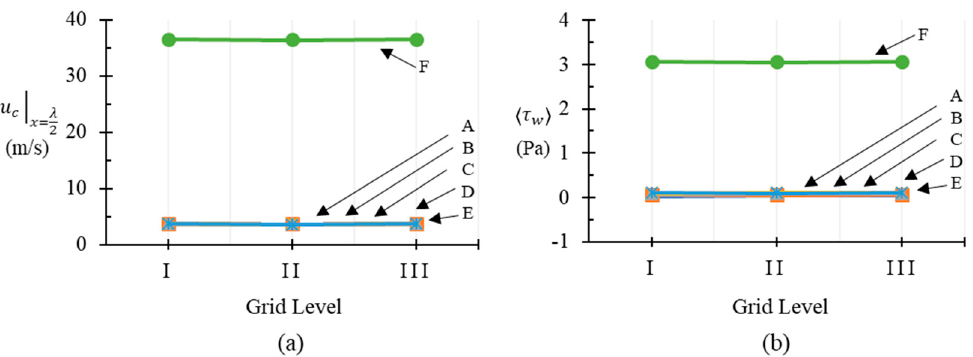
Figure 3. Grid sensitivity test for sets A–F: ( a ) Centerline velocity and ( b ) wavelength-averaged wall shear stress over grid levels I, II and III. Refer to Table 2 for details on grid levels and sensitivity test groups.